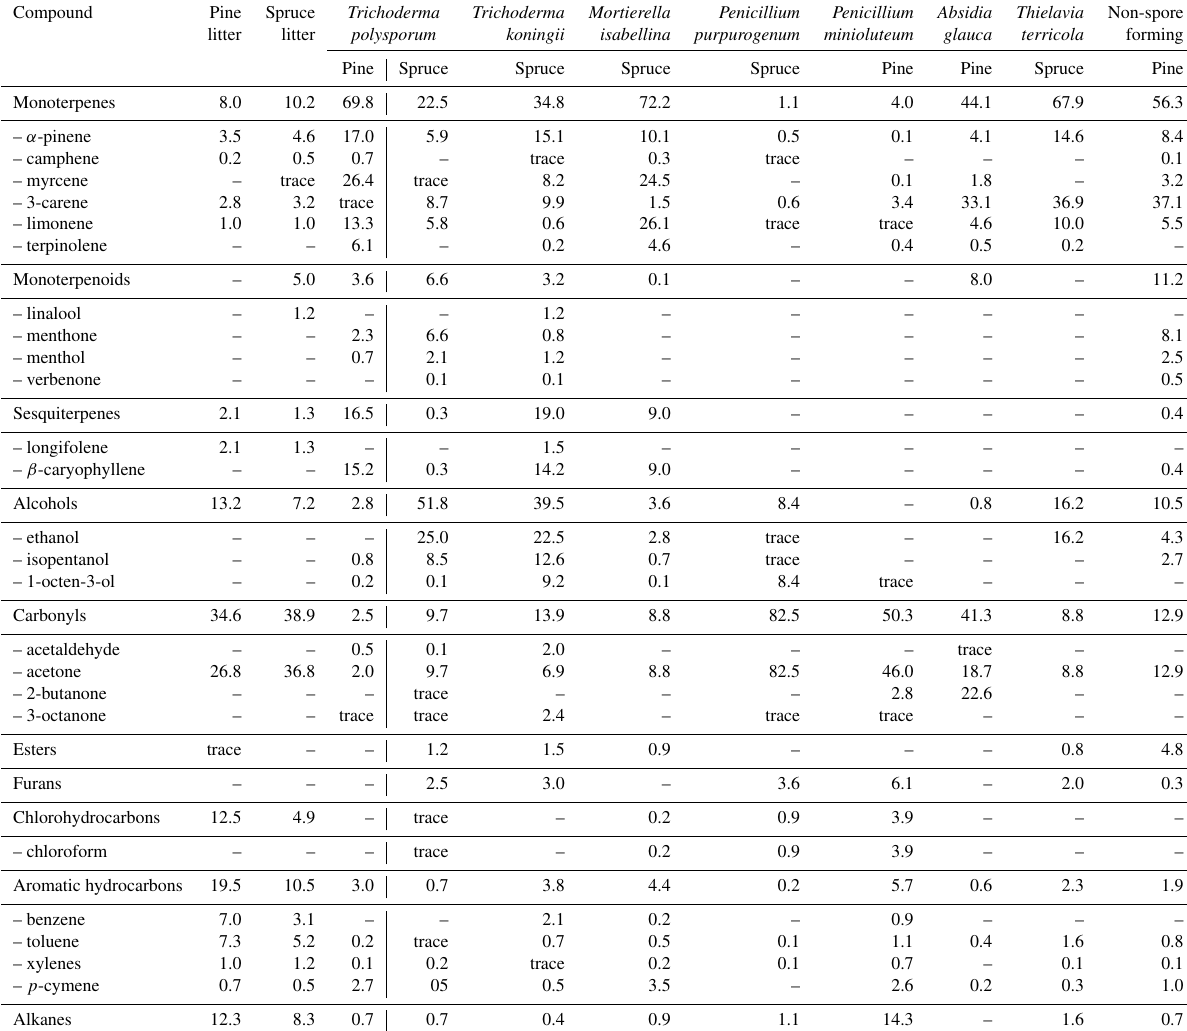
Table 4. Relative composition (% of TIC, total ion current) of volatile compound emissions from “fresh” pine and spruce litter and isolated from litter fungi after 490d of the needle